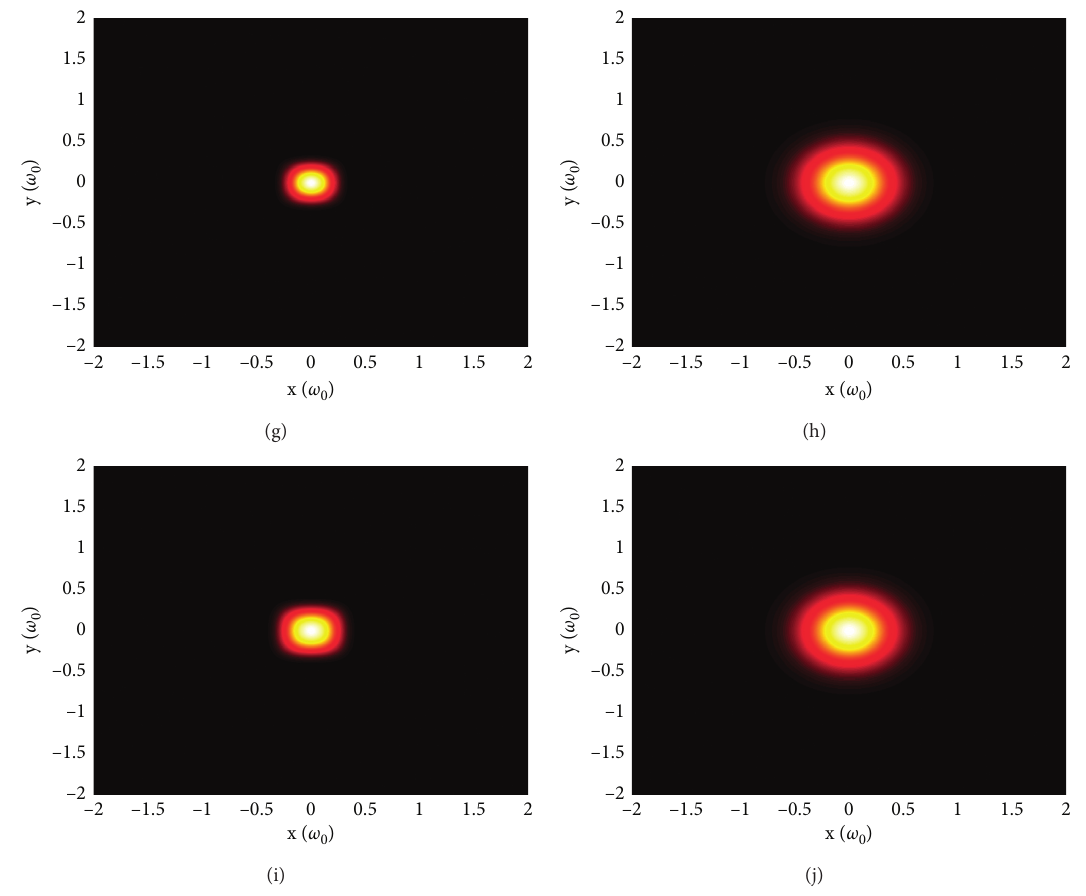
Figure 4: Influence of C 2 on PCAFAB evolution characteristics; other parameters are the same as those in Figure 1(b), and the blue arrow n head denotes each beamlet’s acceleration direction: (a) C n 2 � 10 − 13 m − 2/3 , (z) � 50m; (b) C n 2 � 10 − 13 m − 2/3 , (z) � 100m; (c) C n 2 � 10 − 13 m − 2/3 , (z) � 500m; (d) C n 2 � 5 × 10 − 12 m − 2/3 , (z) � 1000m; (e) zoom in on Figure 4(d) in the first quadrant; (f) C n 2 � 10 − 11 m − 2/3 , (z) � 500m;